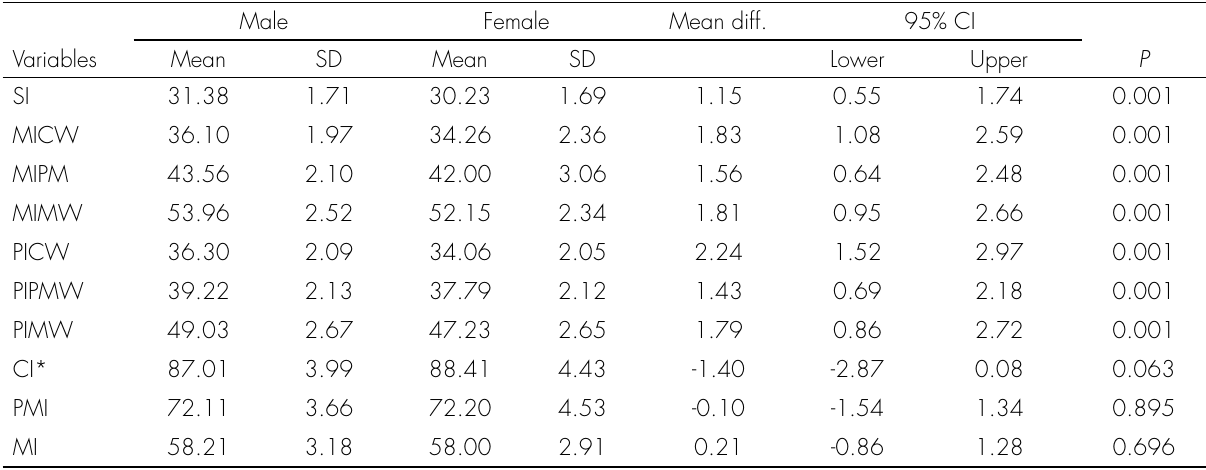
Table I. Comparison of sexual disparities in the sum of the incisors, arch width and expansion indices for the maxillary arch.